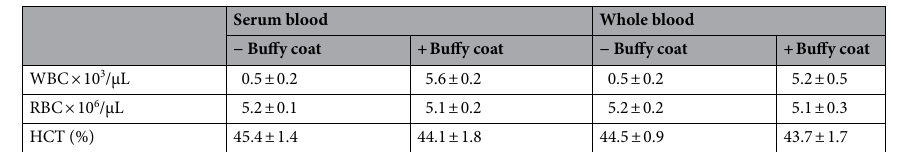
Table 4. Blood cell count of blood and leucocyte-depleted blood and serum blood. Leucocyte-depleted whole blood was prepared by removing the buffy coat after centrifugation. Serum blood was prepared by mixing serum and washed blood cells from the same donor. The number of white blood cells (WBC), red blood cells (RBC) and hematocrit (HCT) were determined using a blood cell counter.